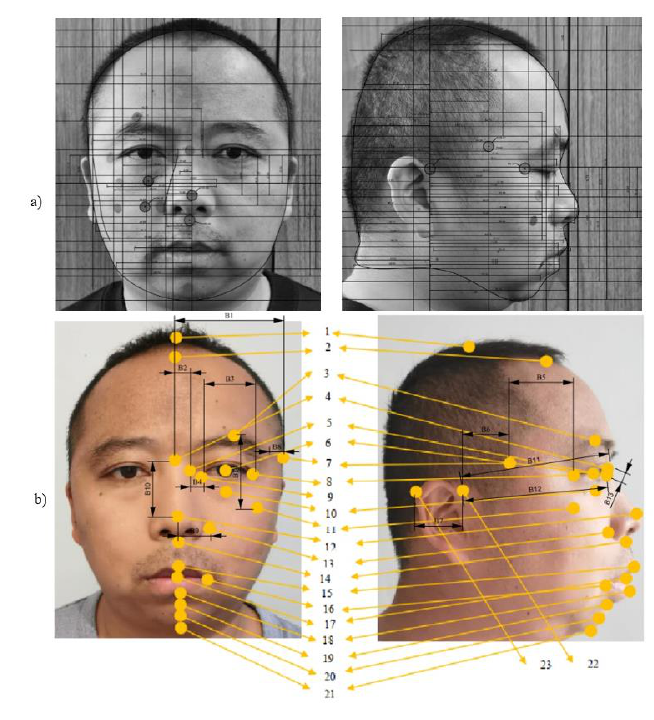
Figure 5. ( a ) Orthogonal photo; ( b ) Feature points for head